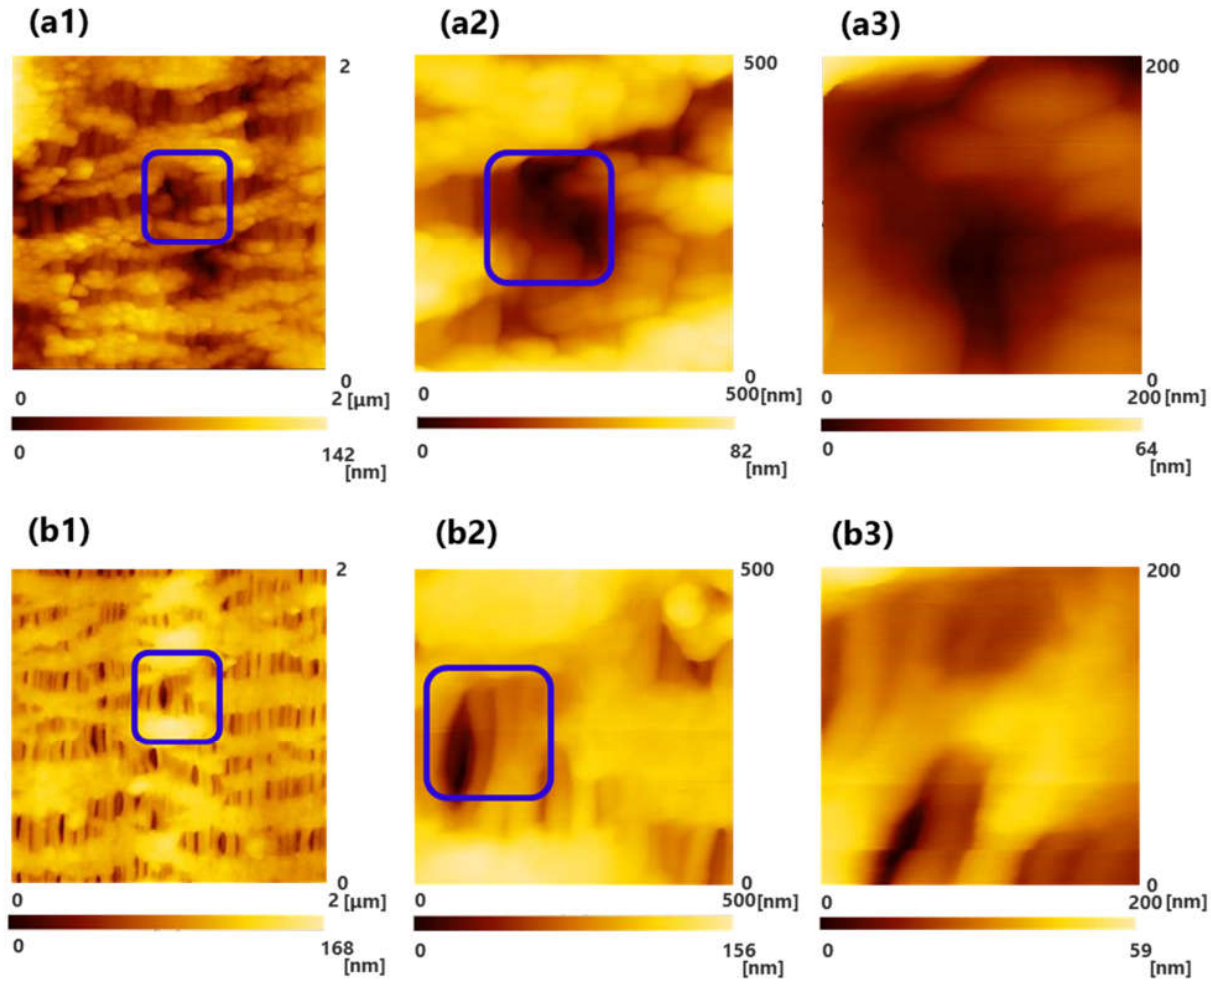
Figure 2. Scanning probe microscopy (SPM) images of oxia ® (dry), ( a ) the surface of inner lumen of the capillary membrane, and ( b ) the outer surface of the capillary membrane: (1) 2000 nm × 2000 nm; (2) 500 nm × 500 nm; and (3) 200 nm × 200 nm, respectively. The image of (3) shows magnified images of the pores enclosed by the blue square in (2), and the image of (2) shows magnified images of the pores enclosed by the blue square in (1).